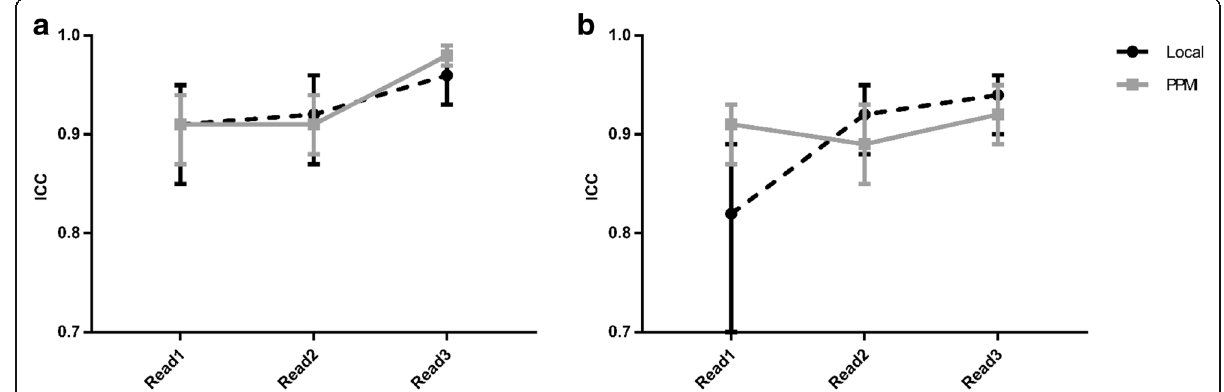
Fig. 6 Inter-reporter reliability (ICC) results for each of the three image reads. Inter-reporter reliability (ICC) results for each of the three image reads for PPMI data and local data. Graph ( a ) is derived from radiologist data only (Rad1 and Rad2); graph ( b ) is from all reporters. Whiskers represent 95% confidence